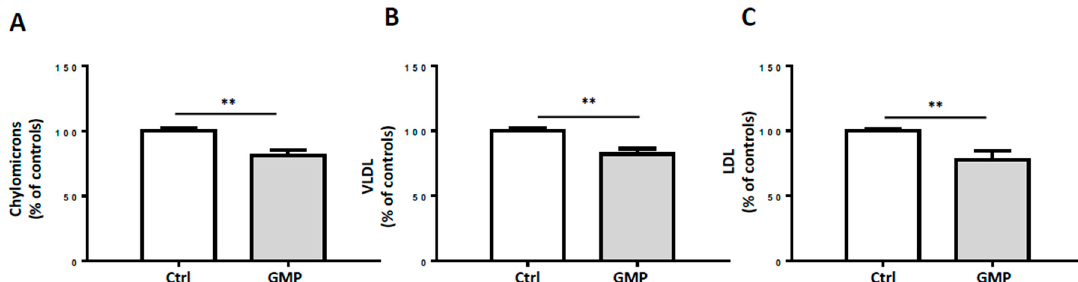
Figure 6. Effects of GMP on lipoprotein production in Caco-2/15 cells. Caco-2/15 cells were